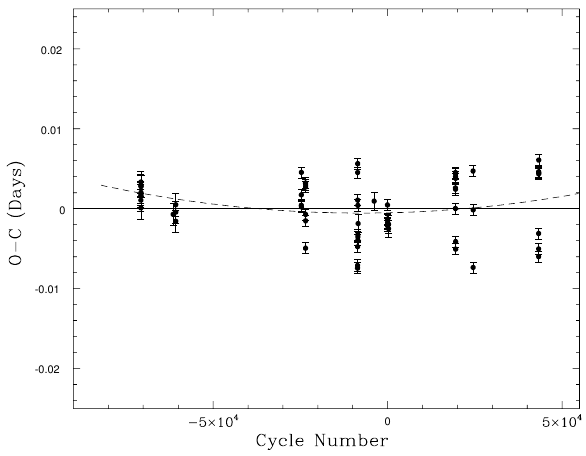
Figure 5: O-C diagram for 63 eclipses of UW CrB with respect to the best-fit linear ephemeris. The dashed line is the best-fit quadratic function. However, the quadratic term is not statistically significant. The verti- cal scatter of the points is due to periodic phase shifting of the eclipses.